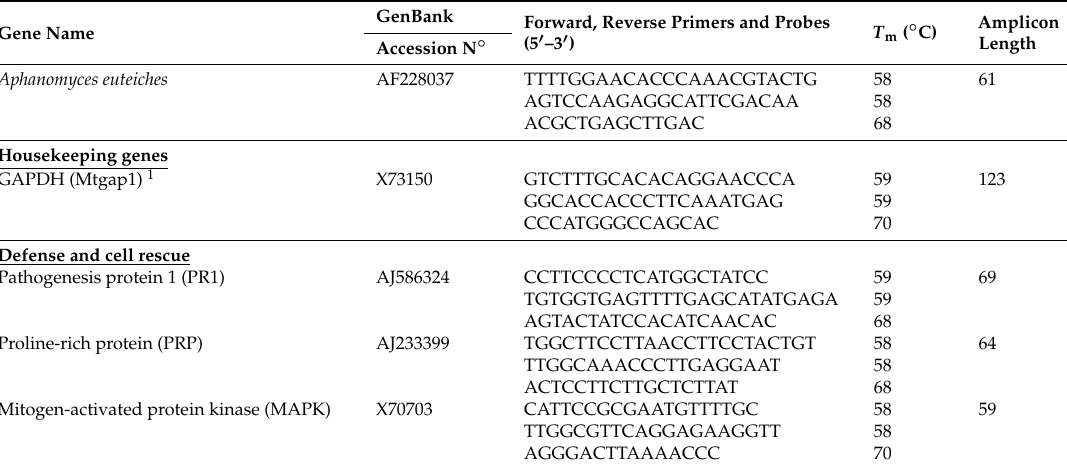
Table 1. Oligonucleotide primer sequences of pea defense